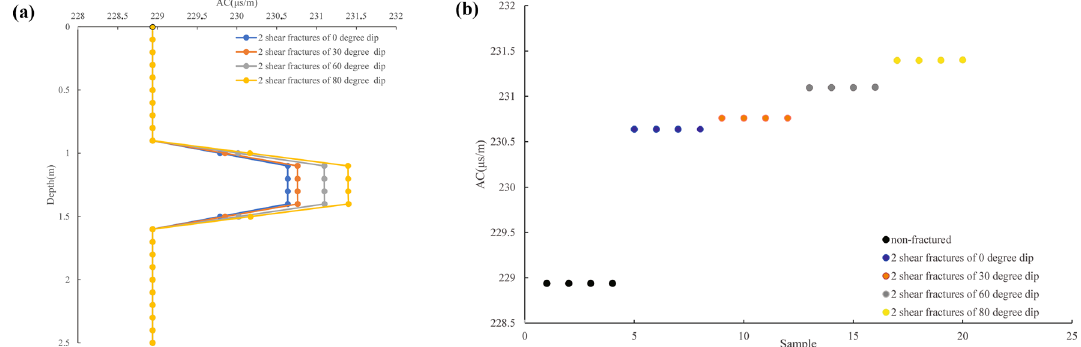
Figure 5. Response characteristics of the acoustic time difference between intact rock and different dip fractures. ( a ) Response characteristics of the acoustic time difference between the non-fracture development (0–0.9 m and 1.6–2.5 m) and fracture development sections (0.9–1.6 m), with four fracture dip angles: 0°, 30°, 60°, and 80° dips. ( b ) Response characteristics of the acoustic time difference between non-fractured sections and different dip